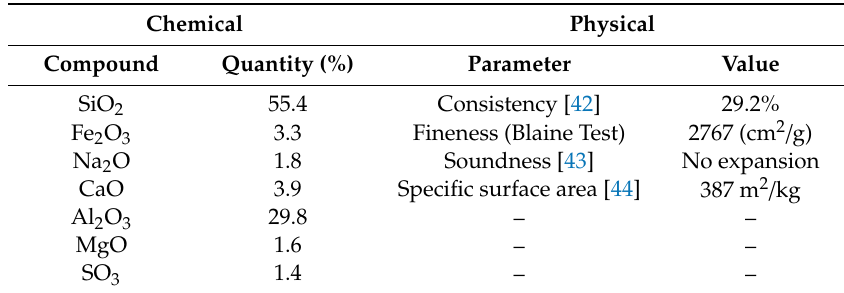
Table 2. Characteristics of fly ash.